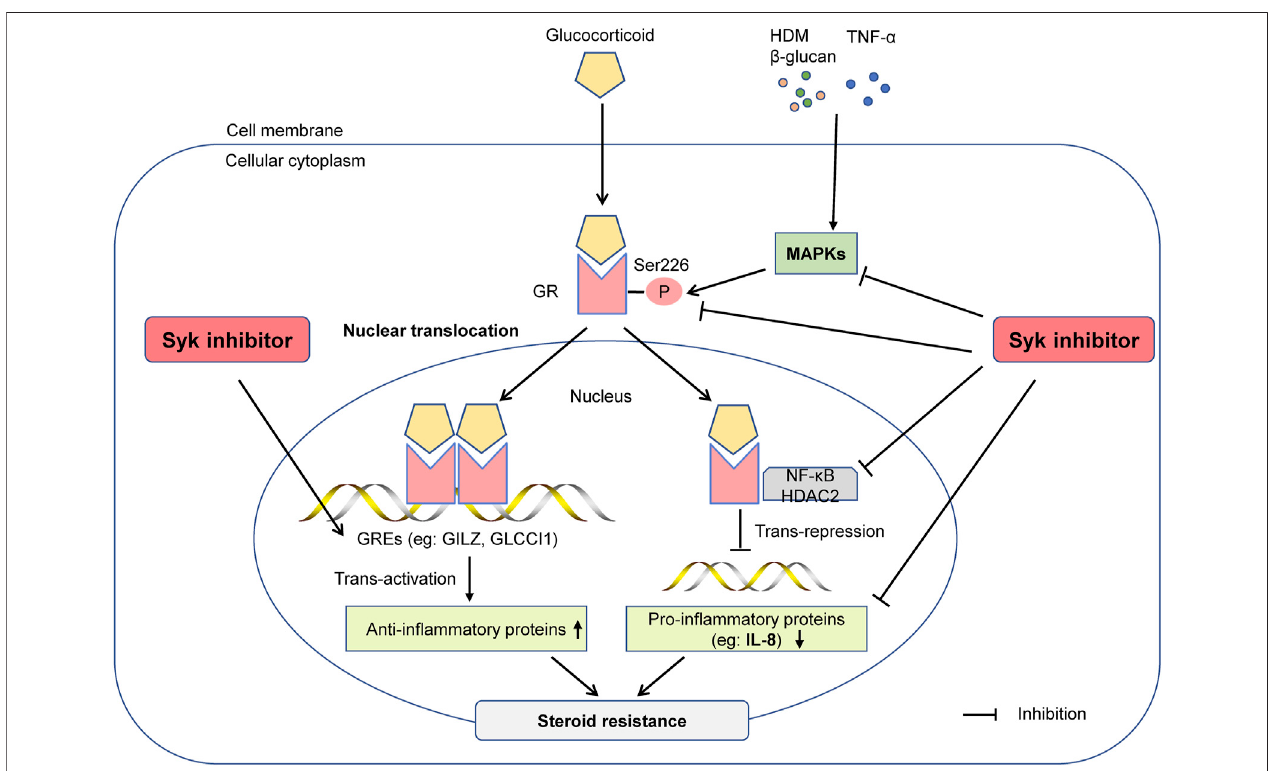
FIGURE 7 | The Syk inhibitor R406 ameliorates glucocorticoid resistance in steroid-resistant asthma. Syk is essential for regulating in fl ammatory signaling in steroid-resistant asthma. The Syk inhibitor R406 can reduce the phosphorylation of GR-Ser226 by inhibiting allergen- or TNF- α -induced MAPK phosphorylation and restore the nuclear translocation of GR. R406 promotes dexamethasone-mediated inhibition of n NF- κ B, restores HDAC2 activity, increases the expression of the glucocorticoid-responsive element GILZ, and reduces the expression of cytokines such as IL-8 to improve sensitivity to glucocorticoids in severe asthma.